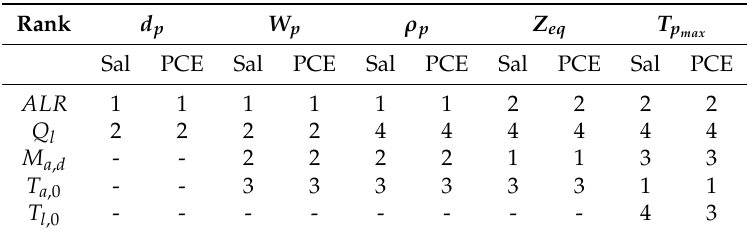
Table 2. Input ranking based on total sensitivity indices computed using Saltelli’s approximation (Sal) with 23,000 samples and third order PCE with 200